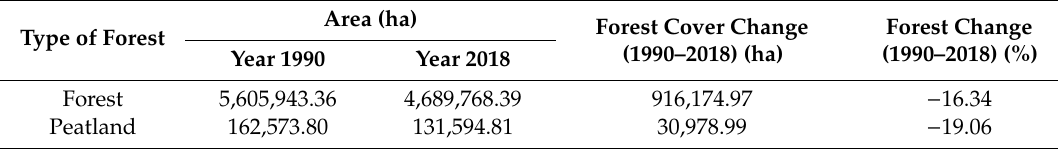
Table 6. Amount of forest cover in Sabah (1990 and